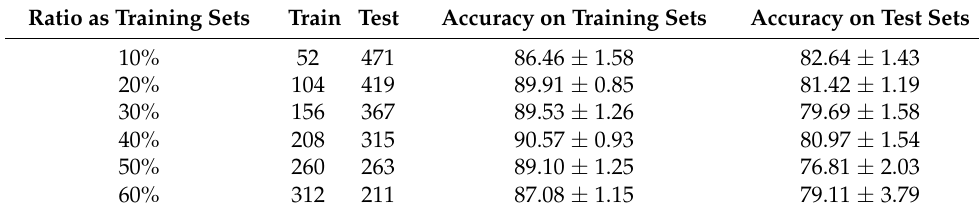
Table 2. The classification accuracy in percentage (mean ± standard deviation) under different proportions of the training set on the Forest dataset.